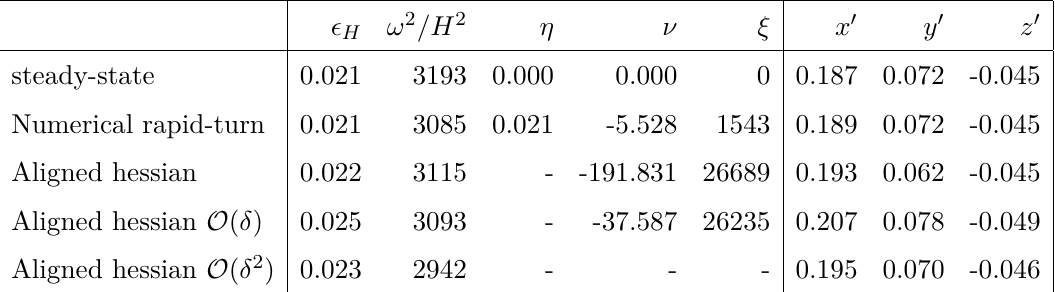
Table 2 . Using parameter set 1, we compare various slow-roll parameters evaluated on: the helix’s steady-state solution, the numerical solution, and the diagonal Hessian approximate solution. The parameters for which we have not analytically computed truncations in the δ -expansion are left blank. At this point, (cid:15) = 7 . 48 , and the Hessian is closely aligned, α ≈ 1 . 4 × 10 − 3 . Our methods V successfully identify the neighborhood of the steady-state solution as rapidly turning, and predict accurate initial velocities. In more detail: (cid:15) is well captured by all methods, and η is accurate to O ( (cid:15) ) . ω 2 is only accurate to O ( ω(cid:15) ) , while ν is particularly poorly estimated and ξ even worse. The initial velocities in the x, y plane are very slightly over-estimated in the aligned Hessian